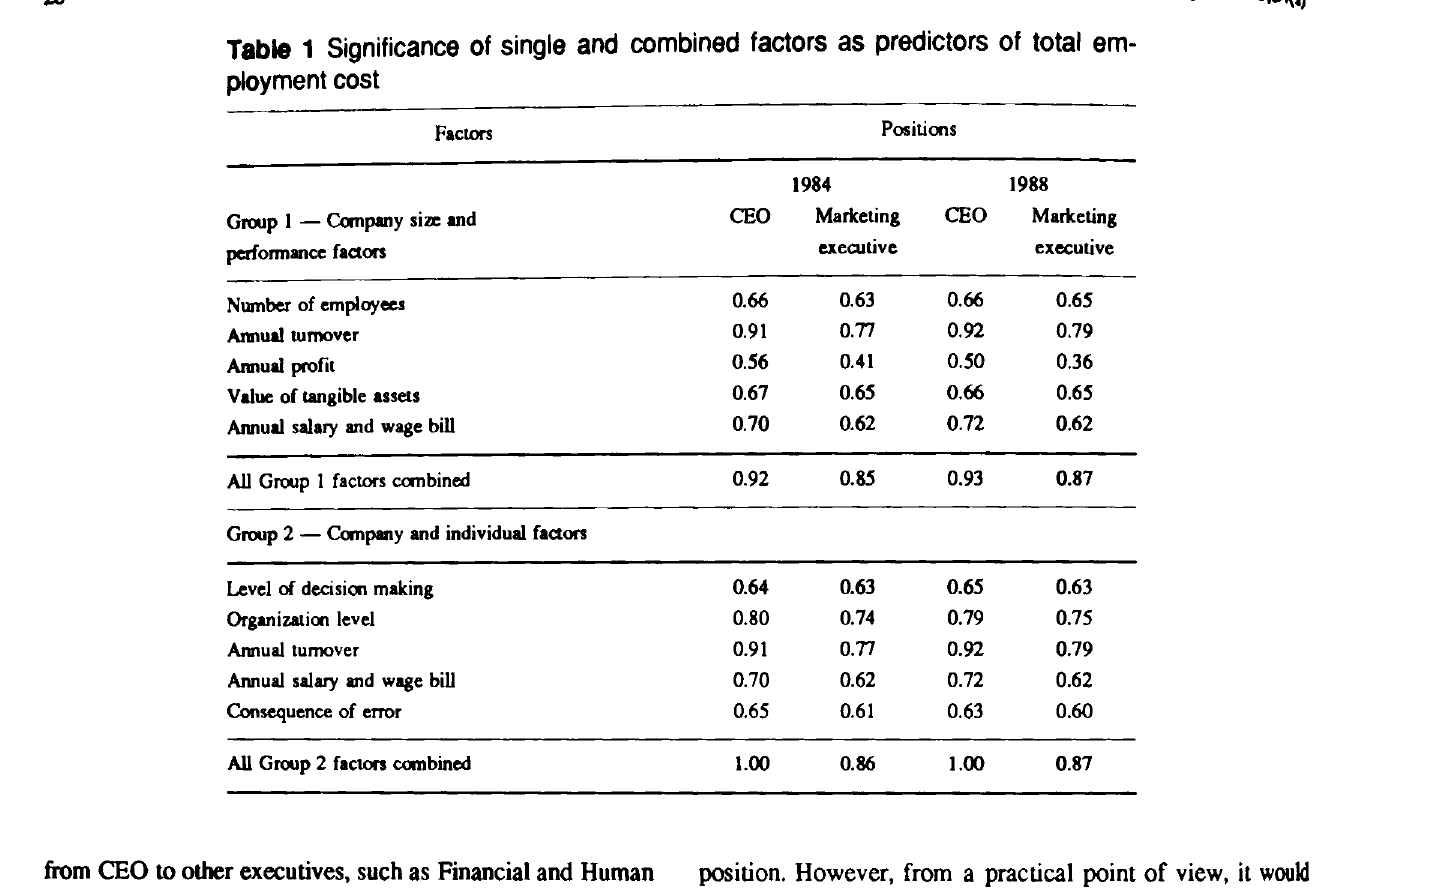
Table 1 Significance of single and combined factors as predictors of total